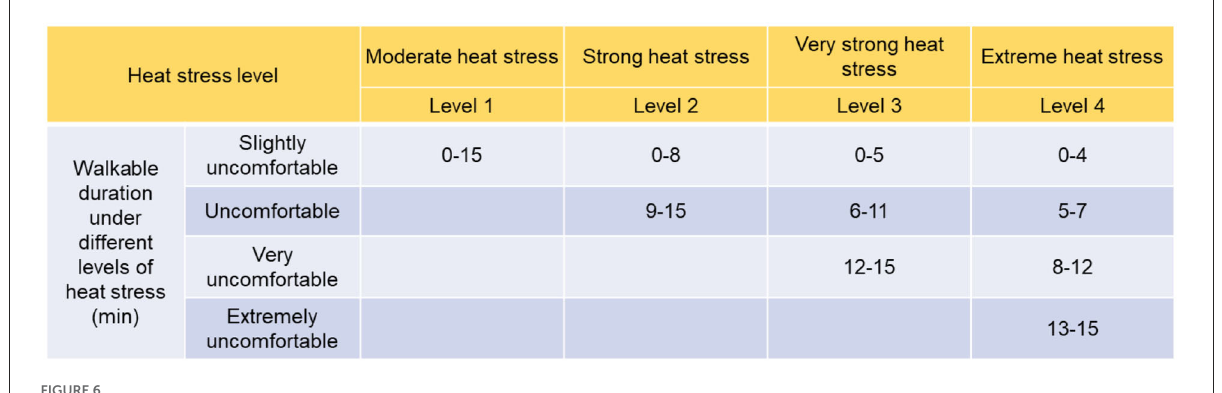
FIGURE6 Heat stress level and its impact on walkable